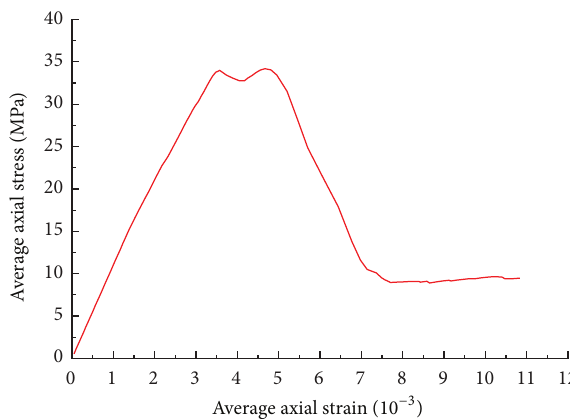
Figure 13: Average axial stress-strain curve for a pillar with width-to-height ratio = 1.5.